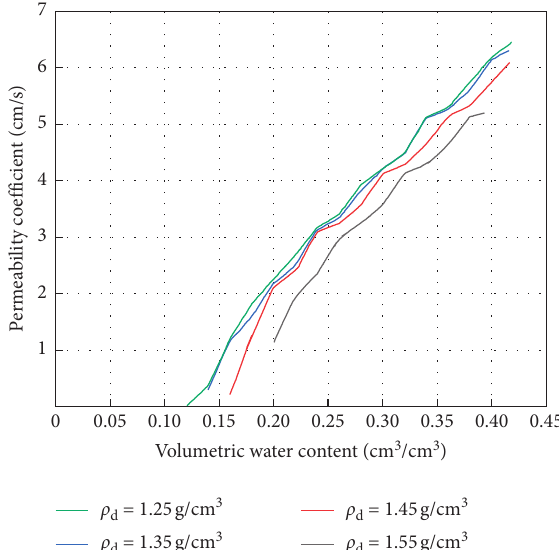
Figure 5: Curve of permeability coefficient with volumetric liquid water content of loess with dry densities of 1.25, 1.35, 1.45, and 1.55g/cm 3 .